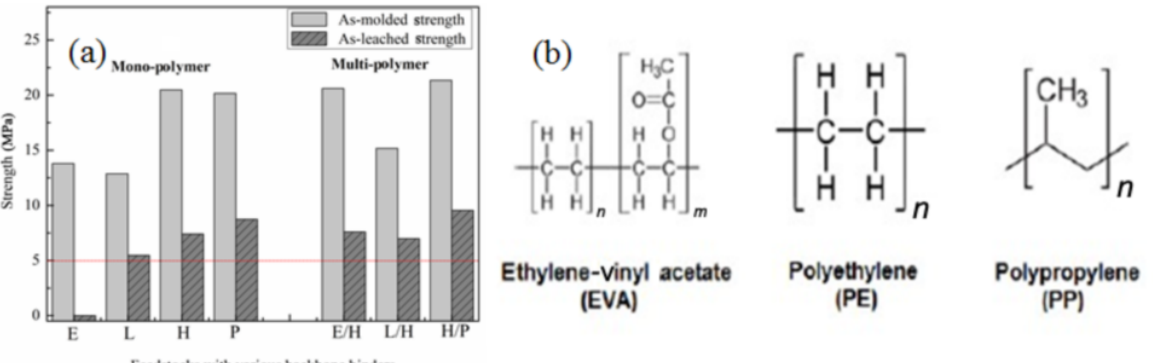
Fig. 4 (a) As-molded strength and as-leached strength of feedstocks with varieties of polymers; (b) the structural formula of backbone binders utilized [19].